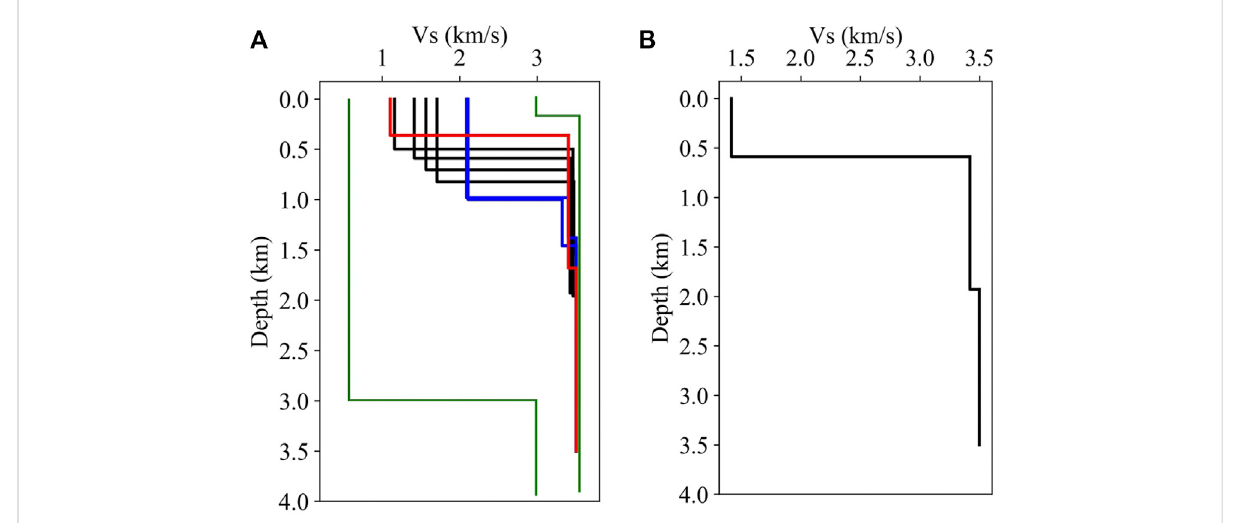
FIGURE 8 The accepted models in Table 2. (A) The green lines are the limits of the model parameters, and 10 6 initial three-layer models were generated between the green lines. The red line represents model one in Table 2, the blue lines represent models six and seven in Table 2, and the black lines represent the other models. (B) The best fi tting model (model four in Table 2).